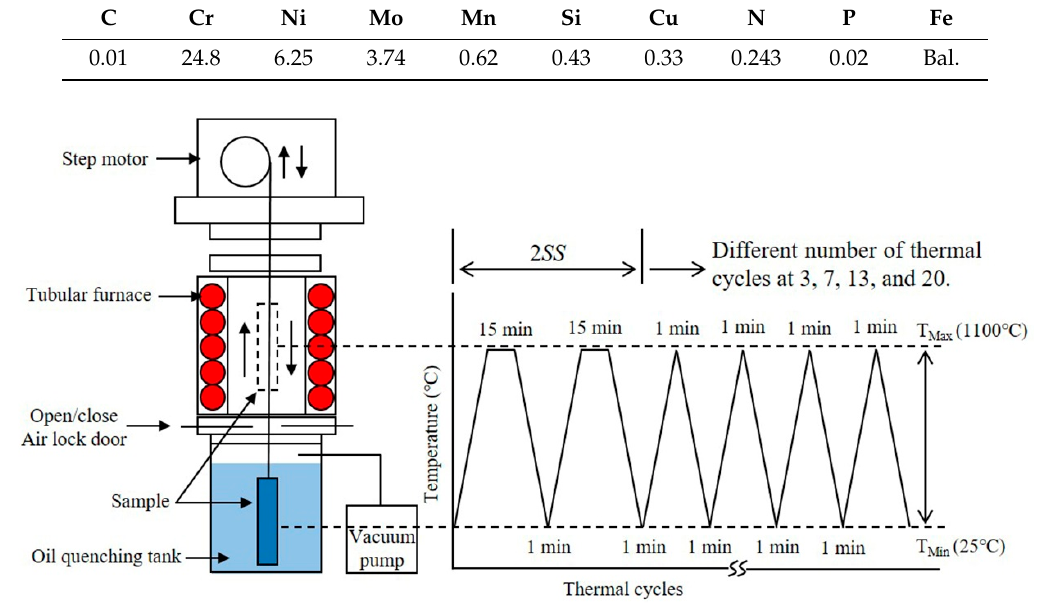
Figure 1. Schematic illustration of the cyclic thermal process. Modified according to [24].